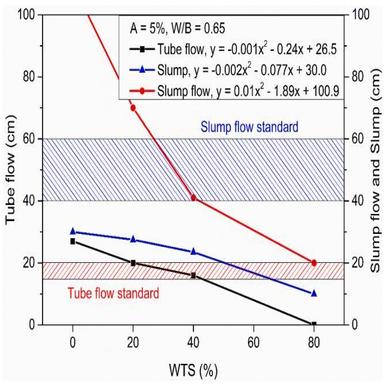
The influence of WTS content on workability in CLSM prepared using a constant w/b of 0.65 and A of 5%.